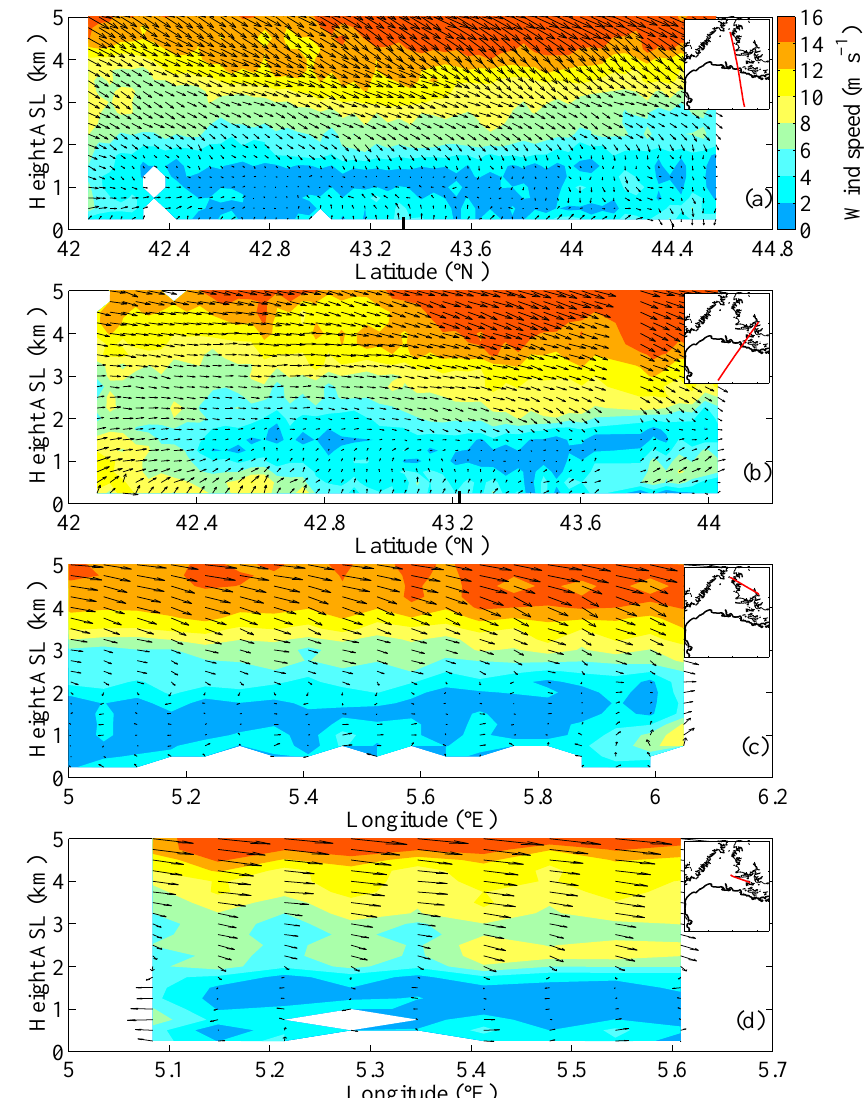
Fig. 5. Same as Fig. 4 but on 25 June 2001 at about 17:00 UTC (the time of the entire DLR Falcon 20 flight is given in Table 1). On panels (a) and (b) , the coastline is at about 43.33 ◦ N and 43.22 ◦ N, respectively.